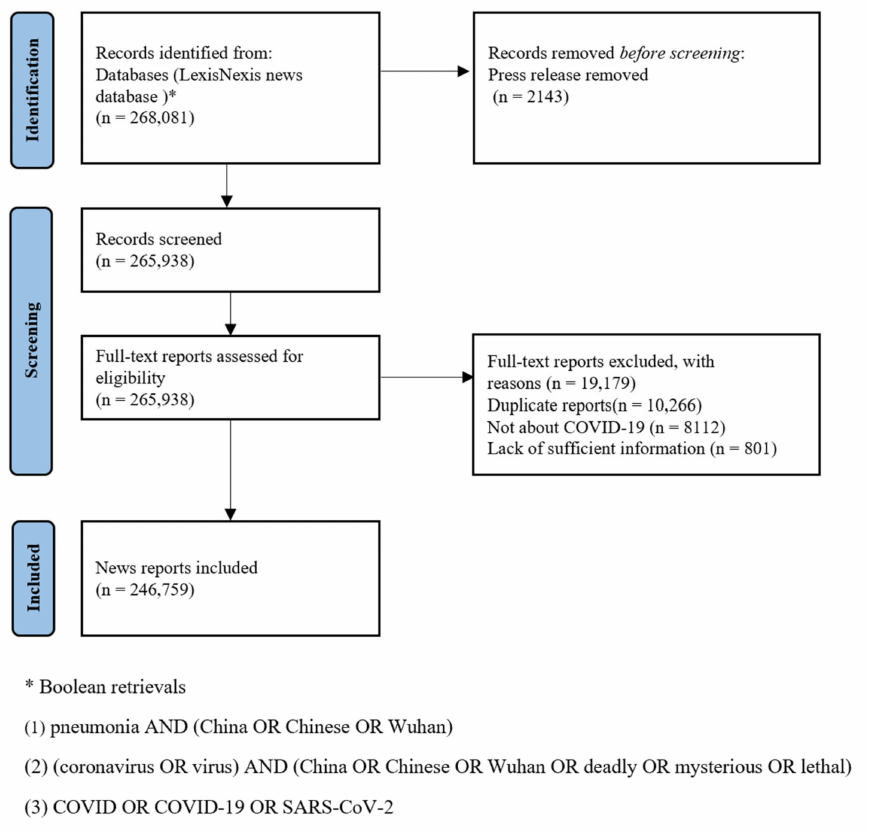
Figure 1. The news report search formulas and selection